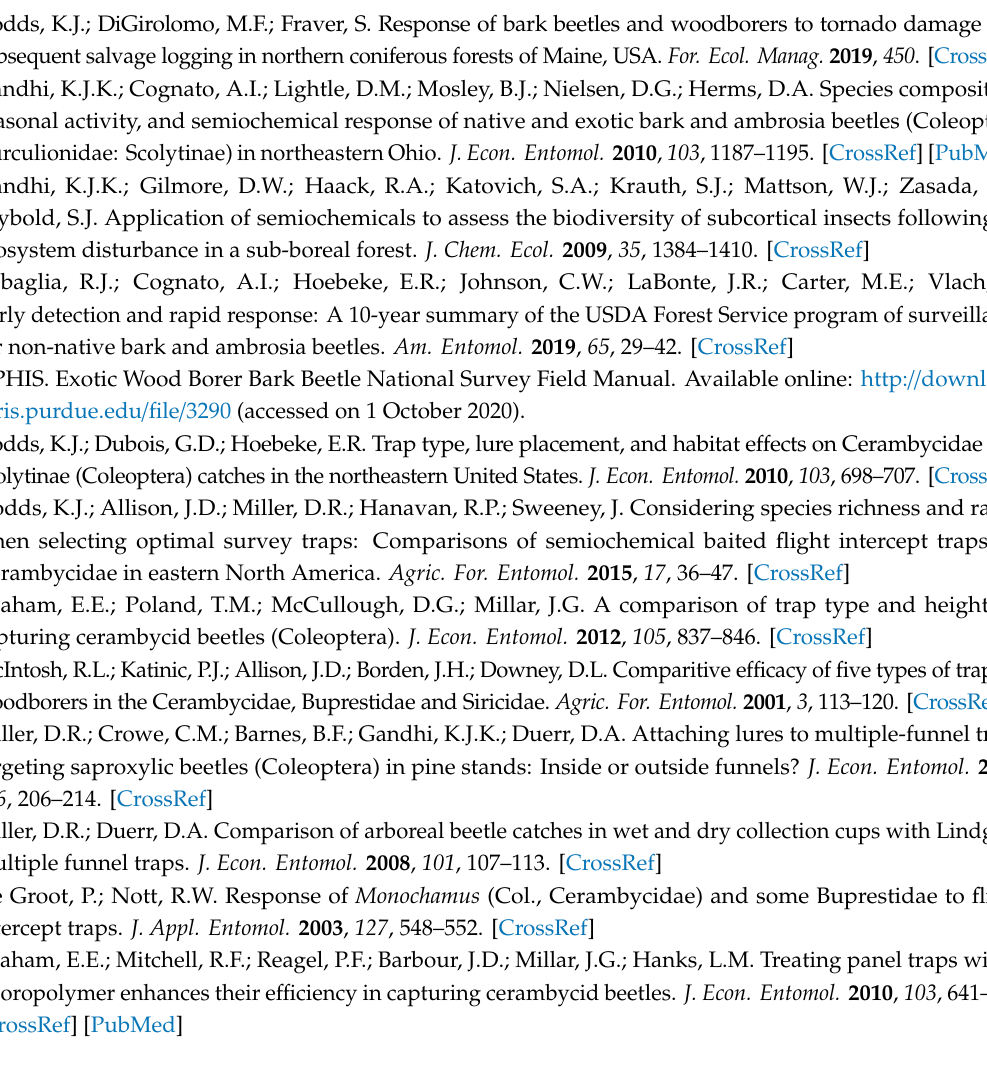
Table S1: Species list and abundance of bark beetles and woodborers captured during Experiment 1, Table S2: Species list and abundance of bark beetles and woodborers captured during Experiment